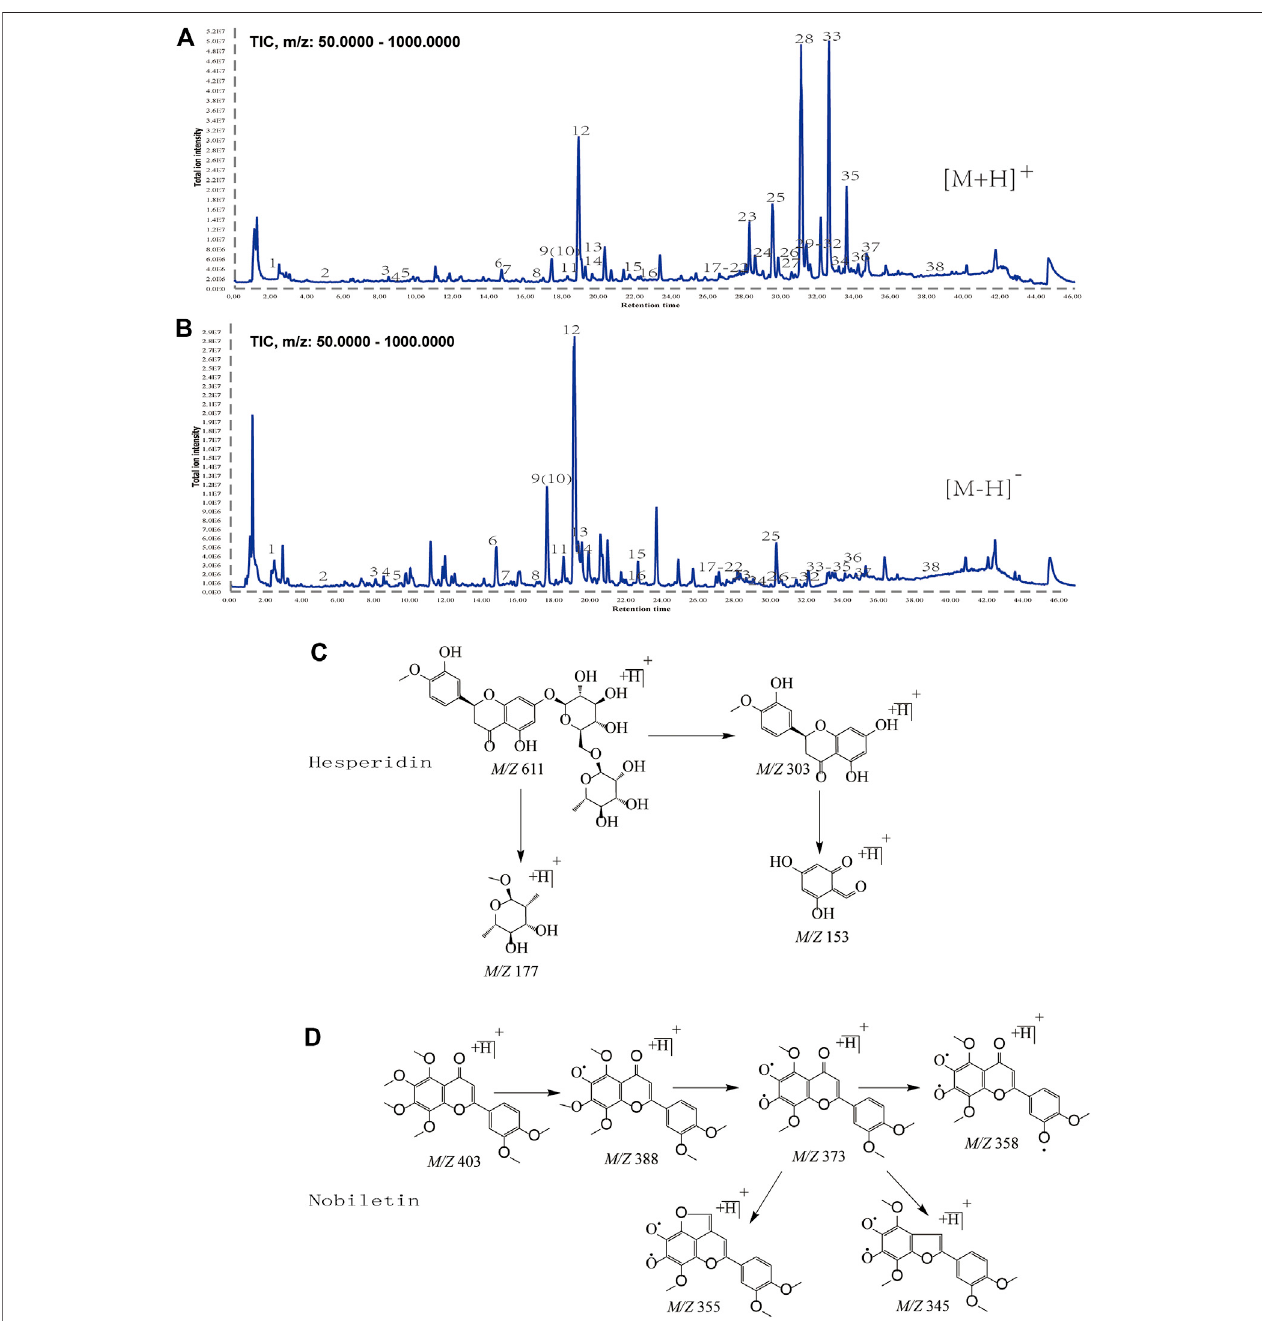
FIGURE2 |(A, B) Total ion chromatogramsof CRPobtained byUPLC/Q-TOF-MS/MS inpositiveand negative ionmode. (C, D) Fragmentation Law ofhesperidin and nobiletin by Mass Spectrometry.